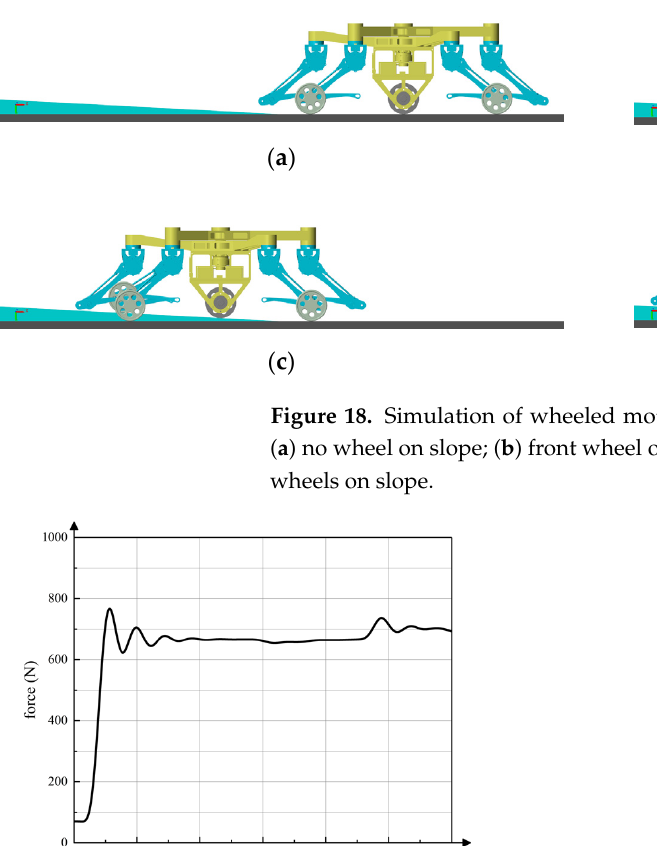
( b ) Figure 17. Vertical contact force between wheels and ground (unilateral passive wheels on slope). ( a ) active wheel; ( b ) passive wheels.